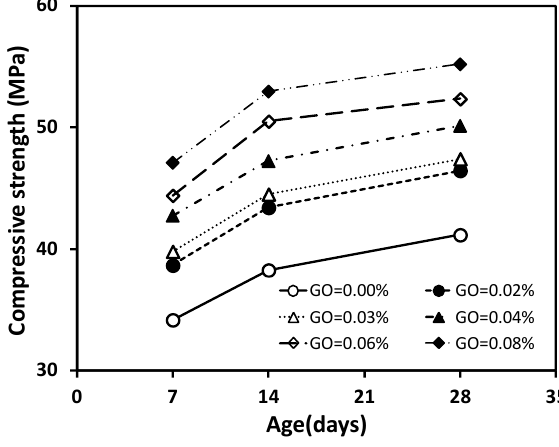
Figure 5. Compressive strength of concrete at different ages.